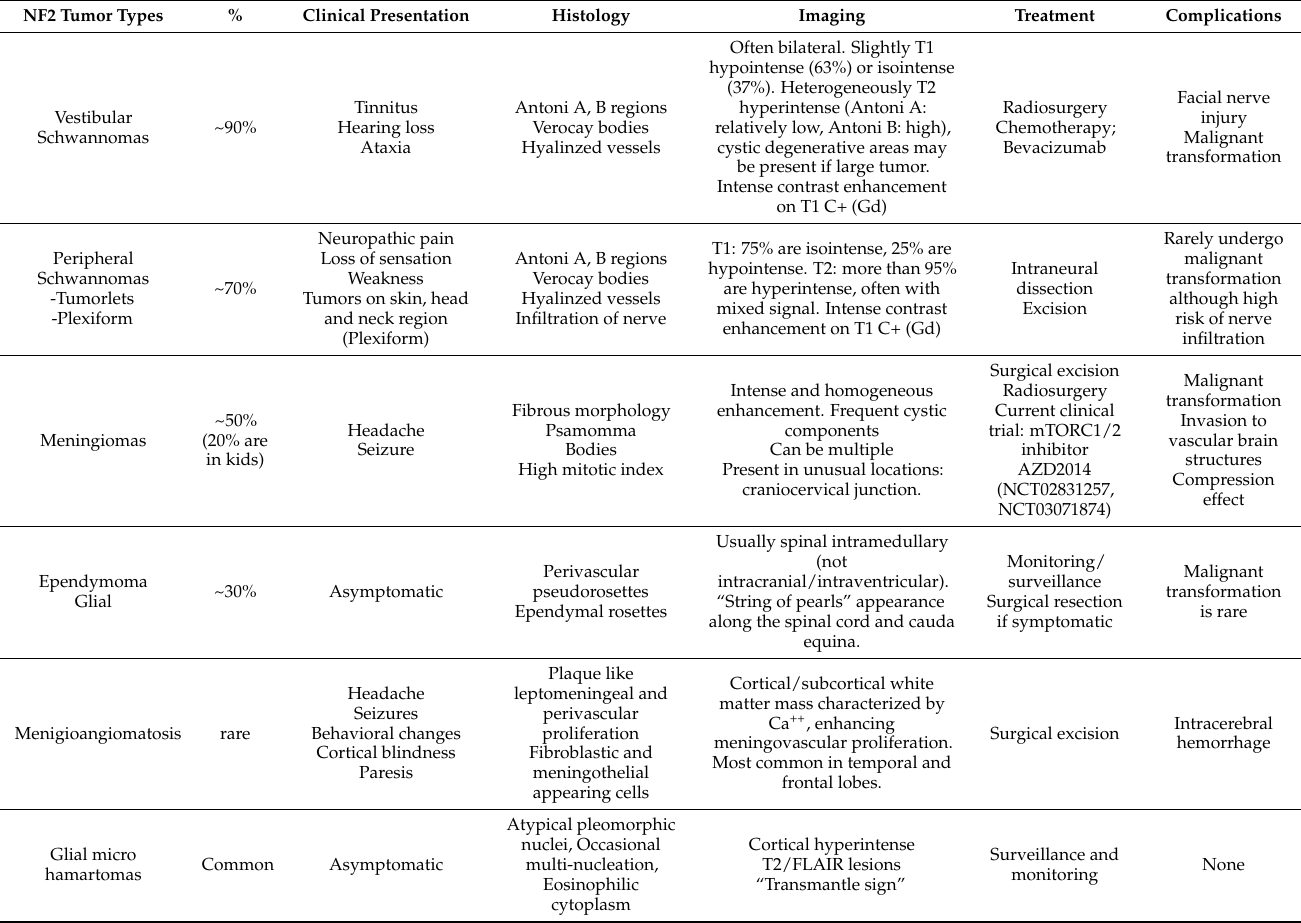
Table 2. Characteristics of NF2 tumor